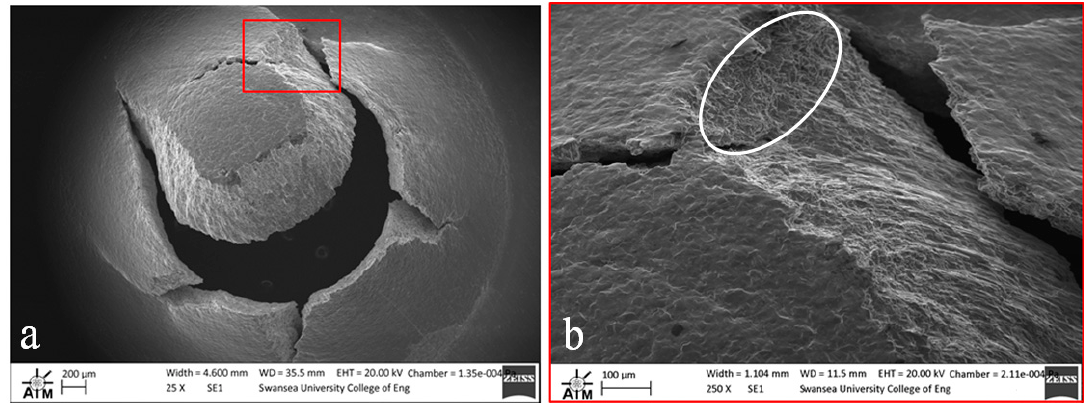
Figure 13. SEM images of fractured SP disc of the forged Ti-6Al-4V material showing ( a ) overall fracture surface and ( b ) typical rupture behaviour.